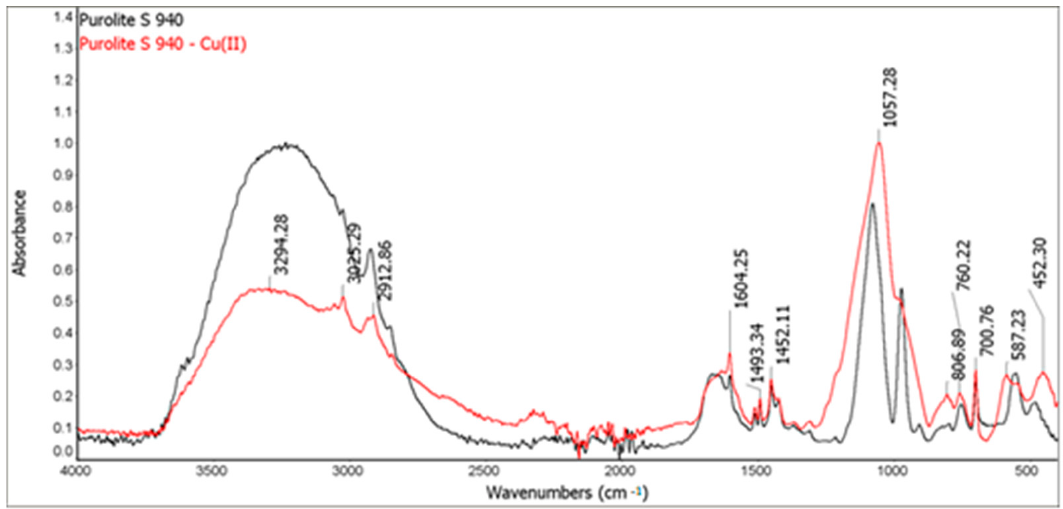
Figure 9. FTIR-ATR spectra of Purolite S 940 before and after the Cu(II) ion sorption process.